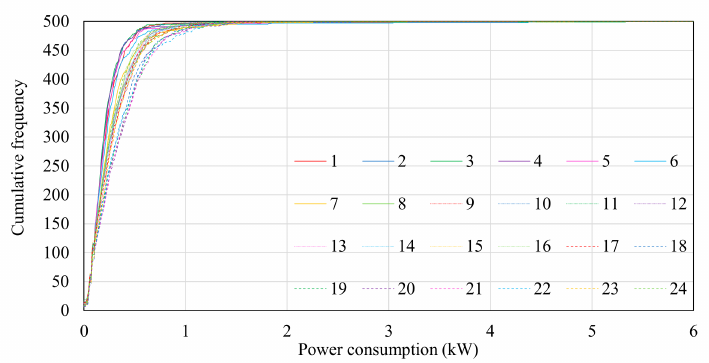
Figure 3. Hourly cumulative frequency distributions in the day of the highest electricity consumption.